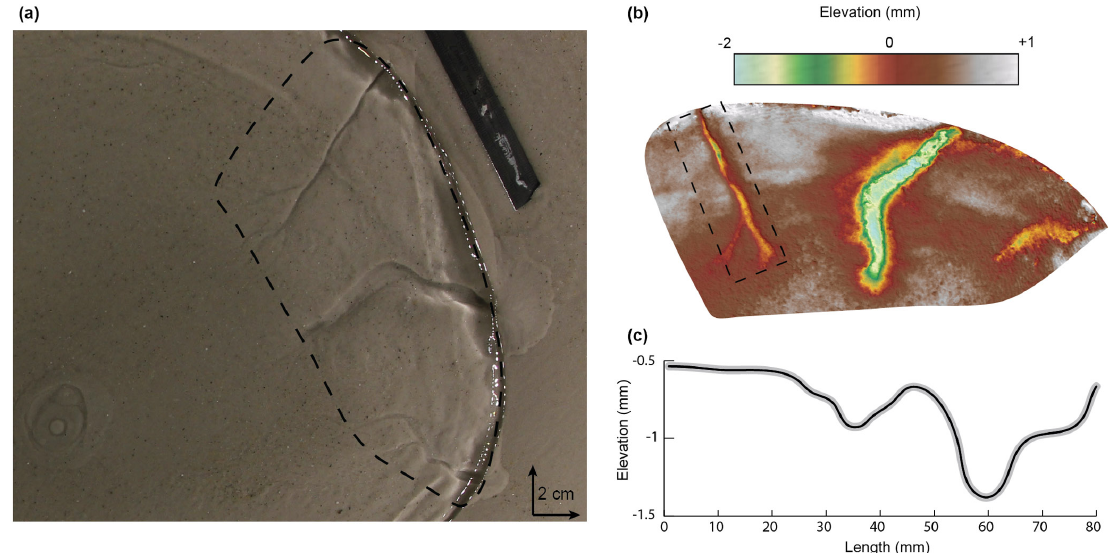
Figure 4. Digital elevation model (DEM) of an experimental tunnel valley and its associated longitudinal profile. (a) Snapshot of the tunnel valley system. (b) DEM of the tunnel valley corresponding to the one highlighted by a dashed box in (a) . (c) Undulating longitudinal profile of the tunnel valley bottom extracted from the DEM in the dashed box shown in (b)